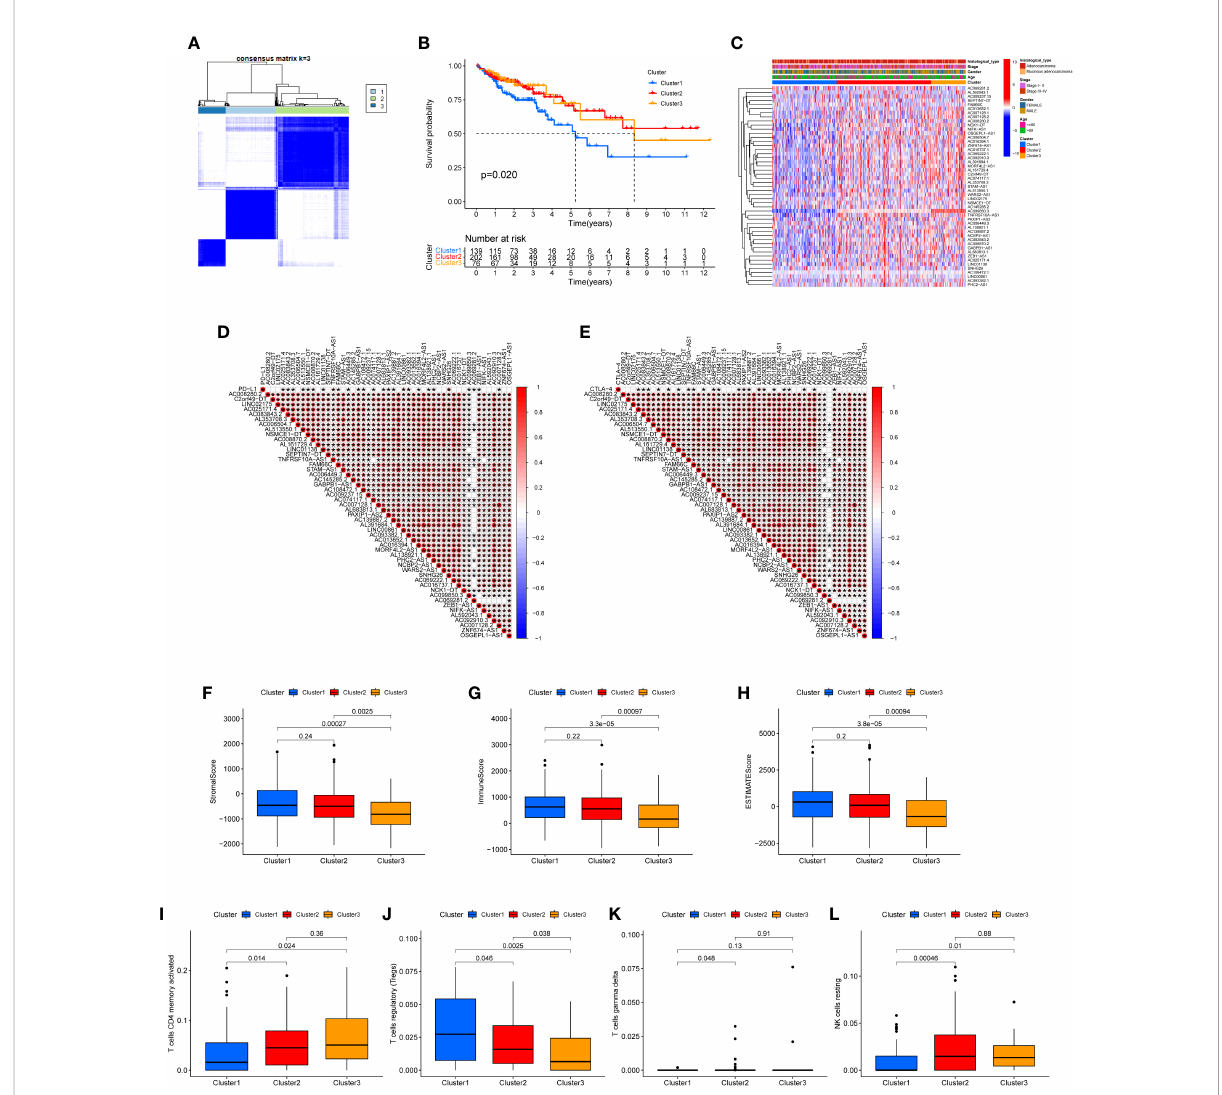
FIGURE 2 Clustering analysis via consensus. (A) When K = 3, the clustering was the most stable. (B) Survival analysis of the three clusters. The prognosis of Cluster 1 is the poorest. (C) A heat map depicting the differences in CRL expression and clinical features between the three clusters. (D, E) The immune checkpoints genes PD-L1 and CTLA-4, as well as prognosis-related CRLs, have a co-expression relationship. Stromal score (F) , Immune score (G) , ESTIMATE score (H) , the abundance of T cells CD4 memory activated (I) , T cells regulatory (J) , T cells gamma delta (K) and NK cell resting (L) in three clusters were